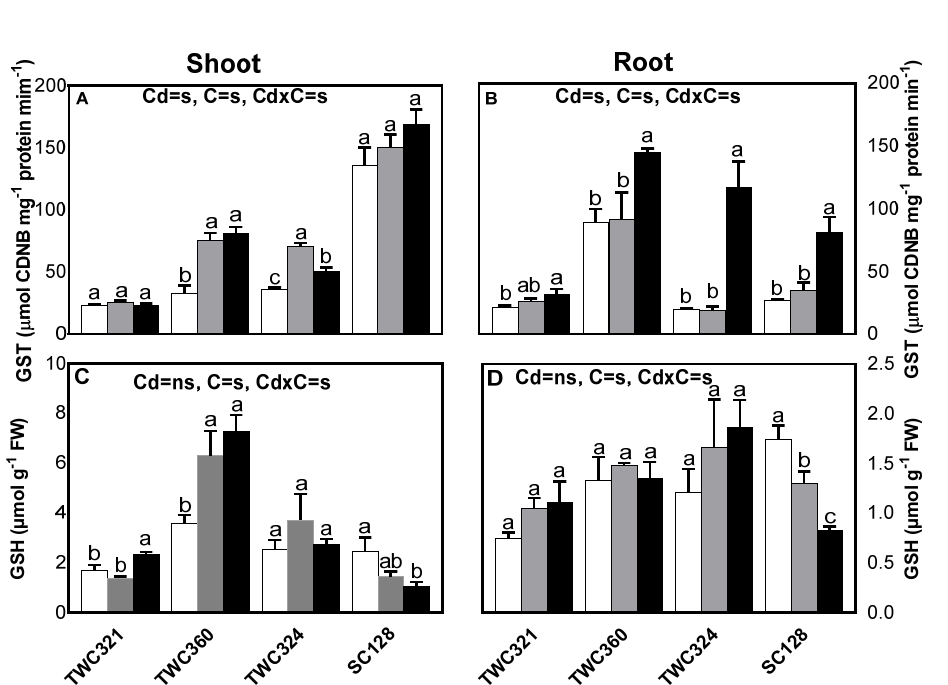
Figure 2. Effect of Cd ‐ stress (C: control, M: mild and S: severe) on ( A , B ) activity of glutathione–S ‐ transferase (GST) and ( C , D ) glutathione reduced (GSH) of shoot and root of maize cultivars, respectively. Values are expressed as means ± SE ( n = 3). Bars with at least one similar letter within each cultivar indicate a non ‐ significant difference ( p ≤ 0.05). Two ‐ way ANOVA was applied to study the effect of the two factors, Cd ‐ stress (Cd) and cultivars (C), as well as their interaction (Cd × C).